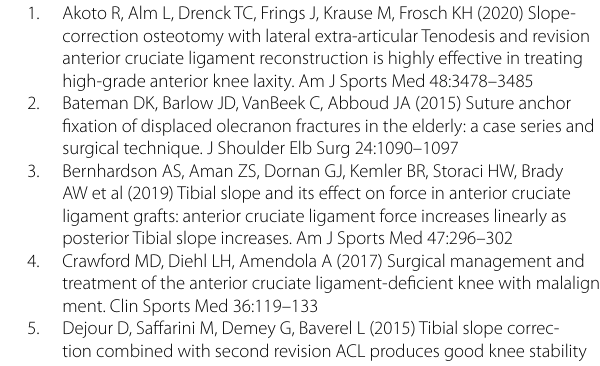
Table 3 Variation in Methods for Performing and Fixating Anterior Closing Wedge Proximal Tibial Osteotomies Akoto et